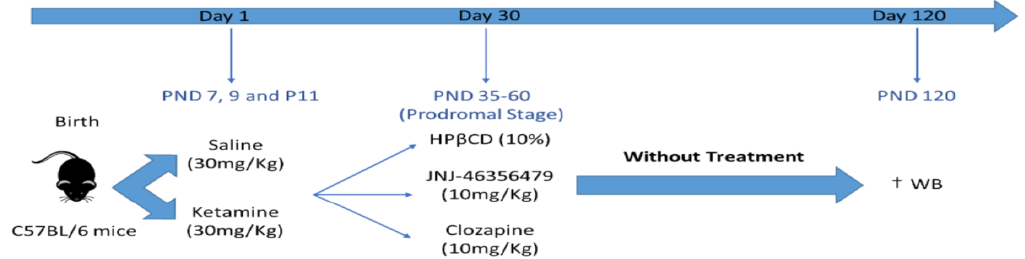
Figure 3. Antipsychotic compounds CLZ and mGlu2r PAM JNJ, among others, may halt both neu- ronal local apoptosis related to dendritic spines and arborization and subsequent nitrosative stress. CLZ, clozapine; PAM, positive allosteric modulator, JNJ, JNJ-46356479.